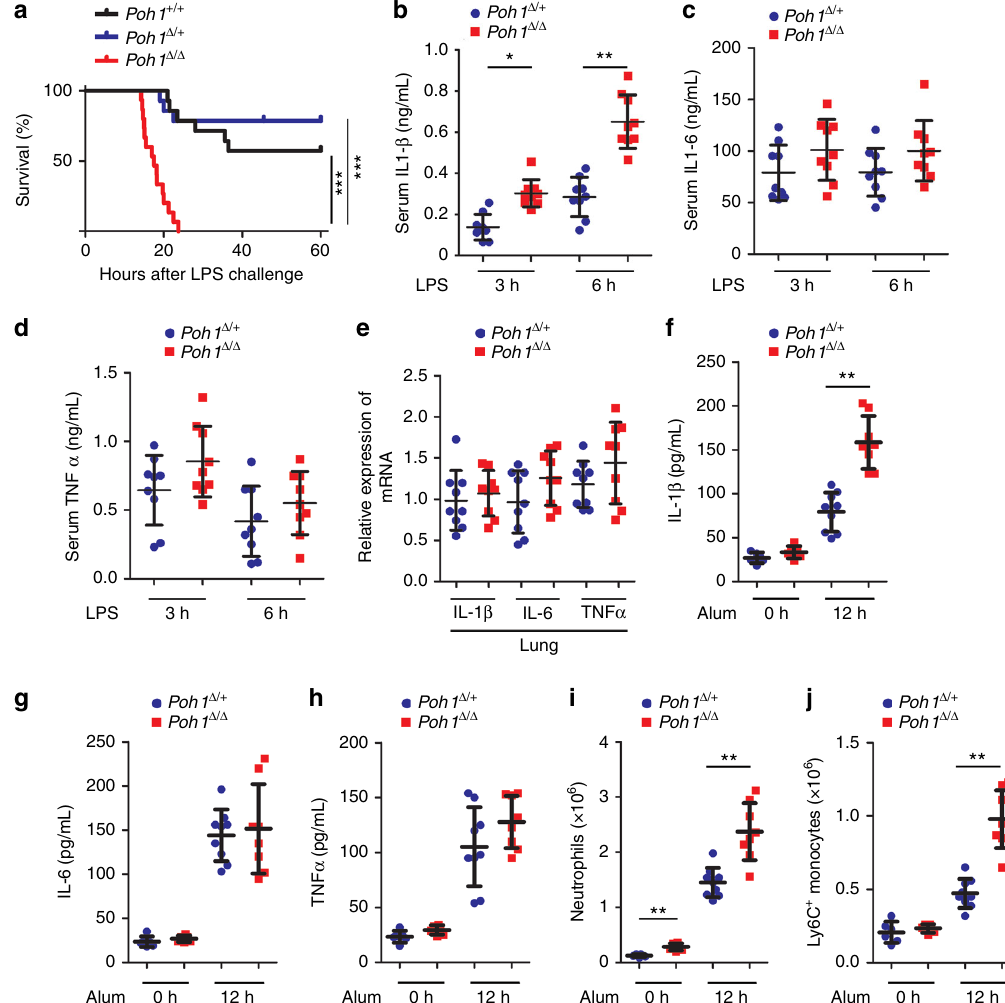
Fig. 1 Myeloid POH1 de fi ciency accelerates in fl ammation in vivo. a Poh1 + / + ( n = 14), Poh1 Δ / + ( n = 14) and Poh1 Δ / Δ ( n = 15) mice were intraperitoneally (i. p.) injected with LPS (40 mg/kg). Survival was monitored for up to 60 h, *** p < 0.001 (asymmetrical log-rank Mantel – Cox survival test). b – d ELISA quanti fi cation of the ( b ) IL-1 β , ( c ) IL-6 and ( d ) TNF α levels in the serum of Poh1 Δ / + and Poh1 Δ / Δ mice upon LPS challenge ( n = 9 per group). e Lungs of Poh1 Δ / + and Poh1 Δ / Δ mice were harvested 6 h post-LPS injection, and then the transcriptional levels of IL-1 β , IL-6 and TNF α were measured by RT-PCR ( n = 9 per group). f-j Poh1 Δ / + and Poh1 Δ / Δ mice were i.p. injected with ( n = 8 – 9 per group) or without ( n = 6 per group) 40 mg/kg of alum crystals, and then peritoneal fl uids were elicited 12 h after the treatment and subjected to analysis of f IL-1 β , g IL-6 and h TNF α by ELISA; absolute numbers of i CD11b + Ly6G + neutrophils or j CD11b + Ly6C + monocytes recruited to the peritoneum were measured. Data are pooled from a three or b-j two independent experiments (mean ± s.e.m. in b-h; mean ± s.d. in i, j ), * p < 0.05, ** p < 0.01 (two-tailed Student ’ s t poly(I:C) stimulation (Fig. 2a, Supplementary Fig. 2d). The TLR9 ligand CpG or IL-1 β , however, failed to induce POH1